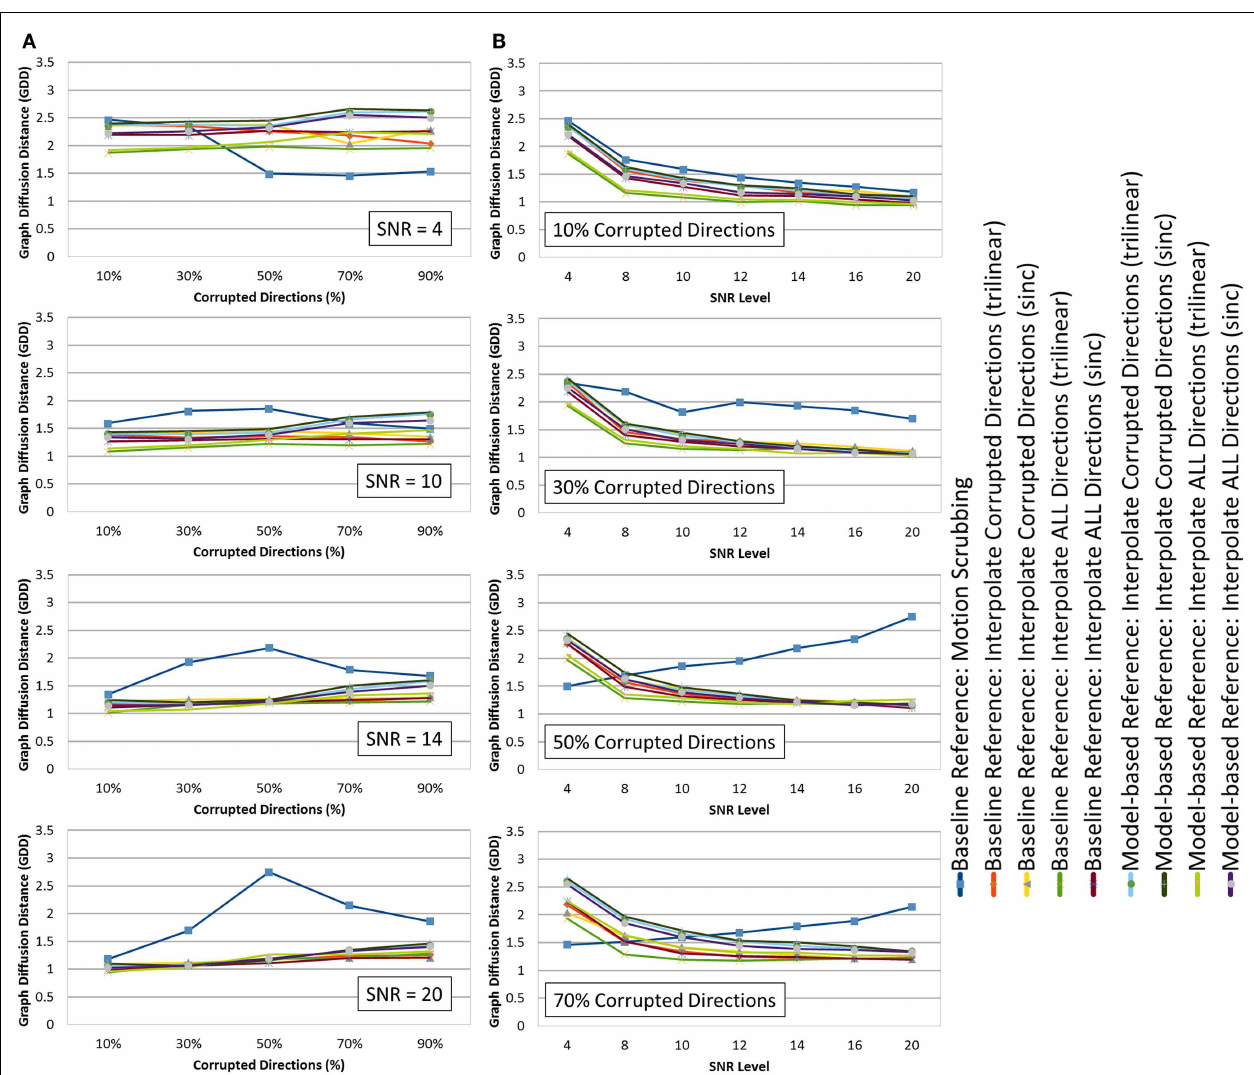
levels for different motion corrupted percentages . Notice the different behavior displayed by motion scrubbing for ≥ 50% corrupted directions, which due to having more short tracts connecting nearby region of interests while being assigned to larger weights in the graph construction